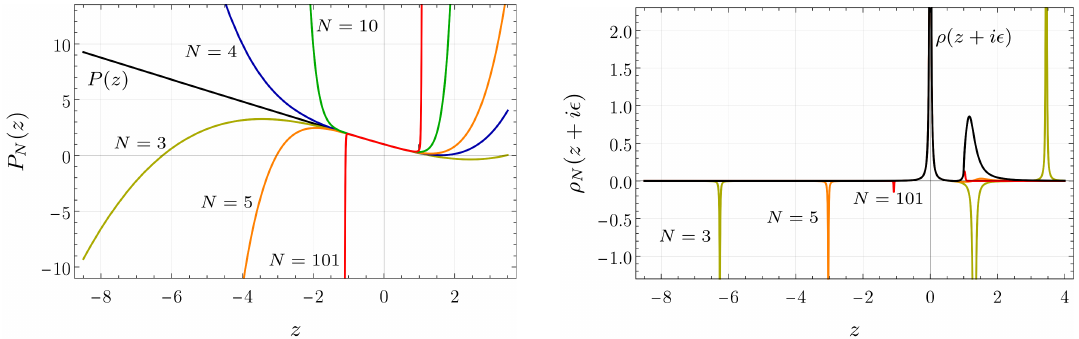
Figure 5 . Although Lee-Wick QED is unitary, and thus characterized by a positive spectral density ρ ( z + i(cid:15) ) , its truncated versions have several unphysical ghosts and its spectral density is not positive. The figure on the right panel (obtained by setting (cid:15) = 0 . 01 ) shows the spectral density ρ ( z ) induced by the function P ( z ) (black line) and by its truncated versions P ( z ) (colorful lines). In N the central peak zone, corresponding to the massless pole, all colorful lines overlap, and are hidden behind the black line. The shape of the P ( z ) -functions are shown for comparison in the left panel. N While the complete spectral function is positive and characterized by a continuum part, its truncated versions ρ ( z ) display several negative-diverging Dirac deltas associated with the fictitious zeros N of P ( z ) , i.e., with the fake poles of the truncated propagator. Moreover, the truncated spectral N function cannot describe the continuum part of P ( z ) , since the resonance necessarily arises as an all-order